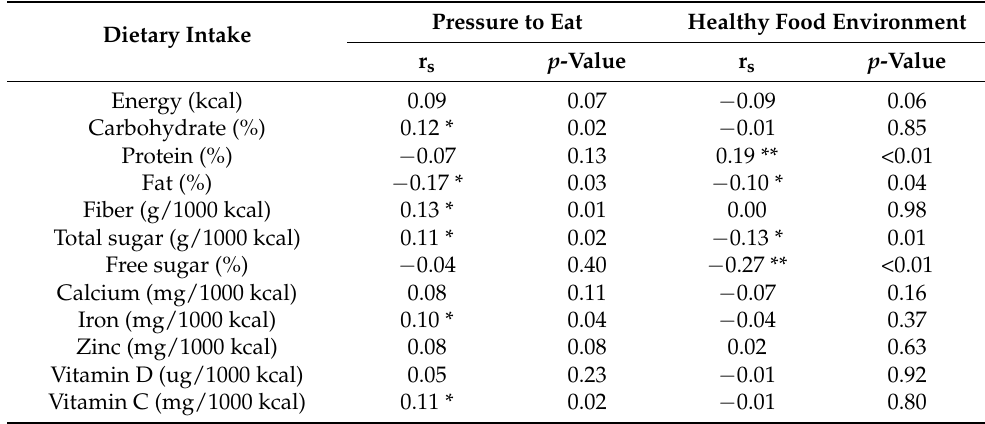
Table 2. Spearman’s correlation of energy and nutrient intake with maternal feeding practices. Pressure to Eat Healthy Food Dietary Intake